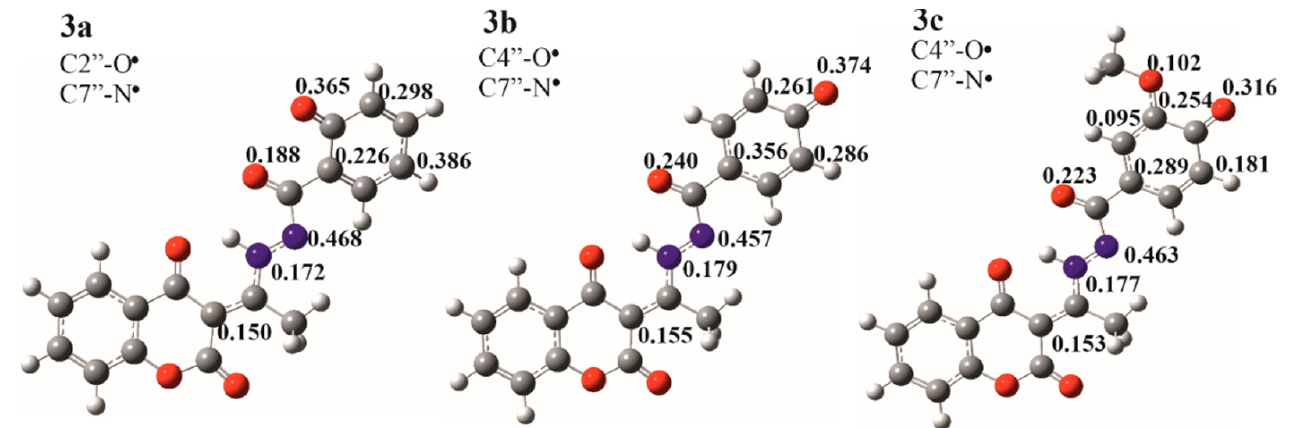
Figure 3. NBO spin delocalisation of 3a , 3b , and 3c biradicals obtained through the DHAT mechanism.